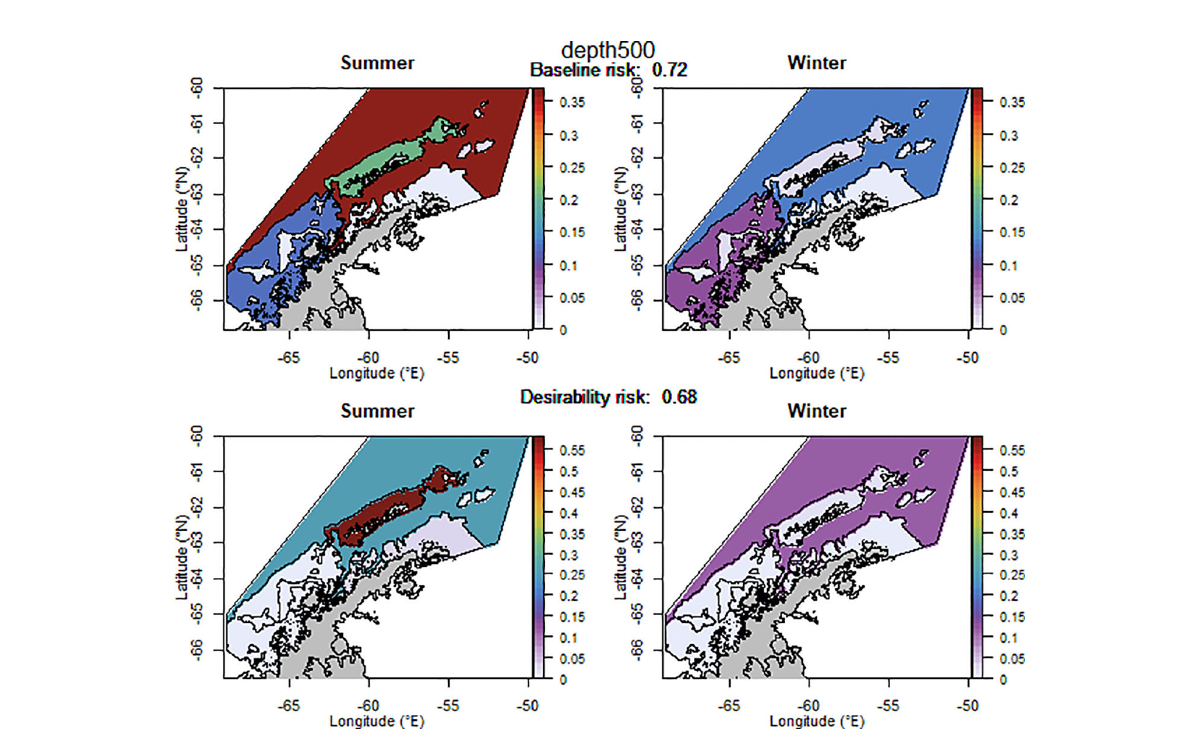
FIGURE 4 The proportion of the annual krill catch limit that could be taken from each management unit (delineated using a simpli fi ed version of the 500 m isobath) during summer and winter when the initial analysis for the risk assessment was implemented (i.e. unadjusted layer for winter krill and assuming even catch distribution within management units). Values sum to 1 across all management units and both seasons for each of the baseline (upper panel) and desirability (lower panel)